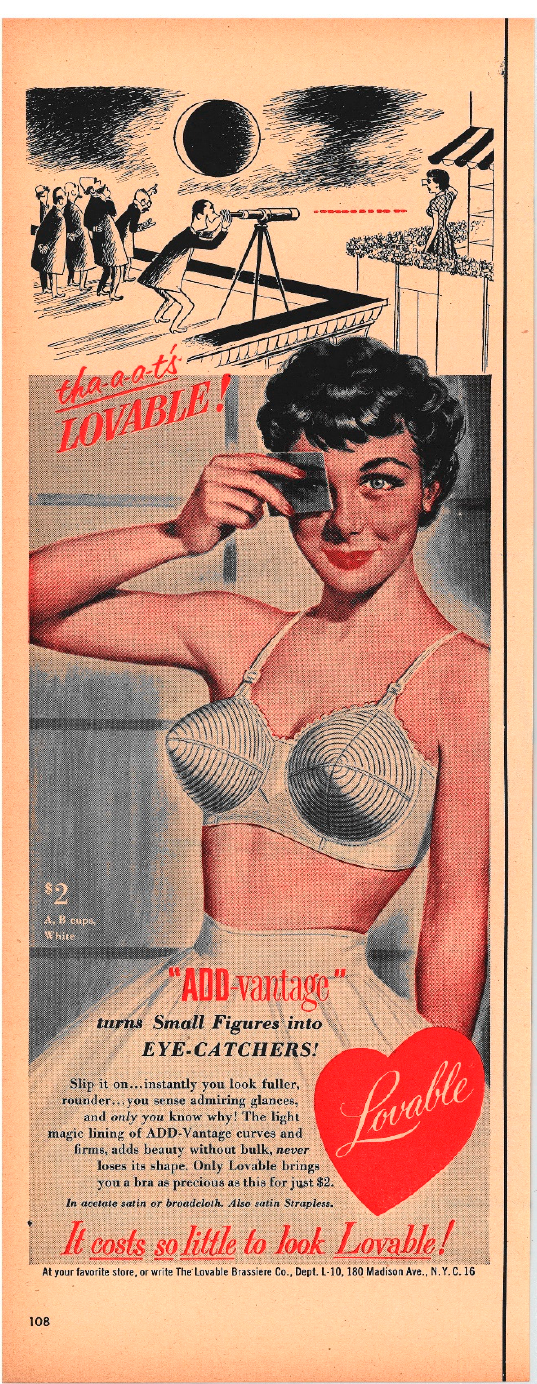
Figure 2. This 1953 ad for Lovable pointed bras ties that year’s solar eclipse to the customer’s goal to be “eye-catching”. The illustration suggests that the bullet-brassiered woman on the rooftop has triumphed in lovability by converting the astronomer to voyeur.